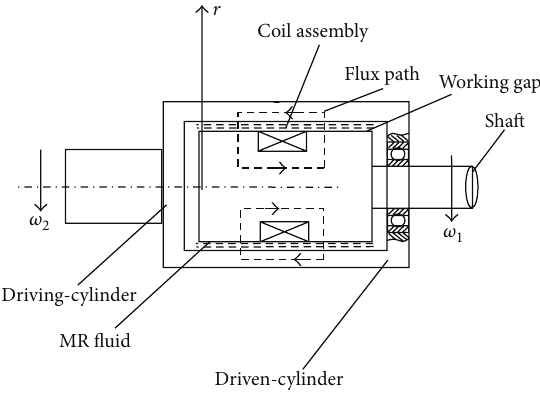
Figure 3: The curve of shear stress versus shear strain rate.